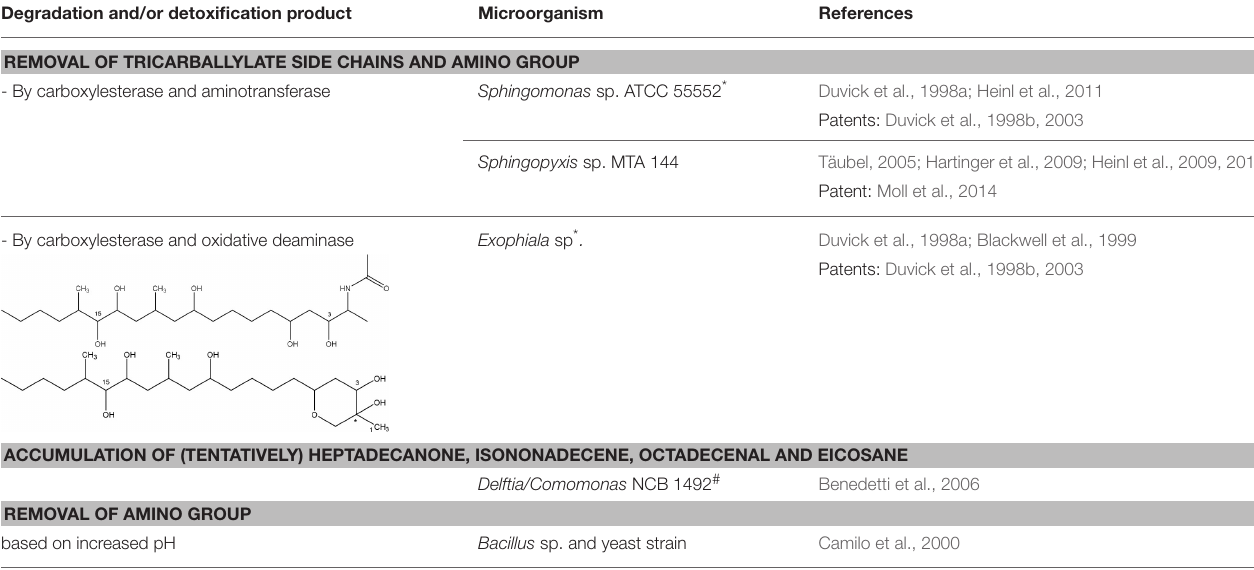
TABLE 2 | Degradation and/or detoxification products of